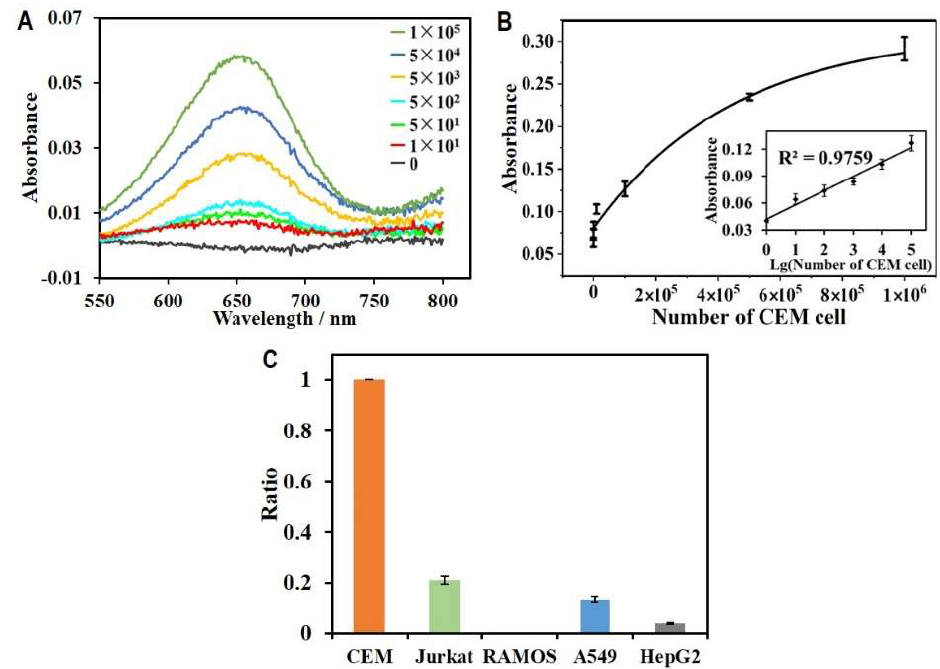
Figure 5. Application of the HGN-based aptasensor for quantification of CEM cells. ( A ) The UV-vis absorption spectra recorded by the HGN-based aptasensors for detecting various concentrations of target CEM cells with cell amount from 0 to 10 5 . ( B ) The relationship between absorbance intensity and the cell concentration. The inset shows the linear calibration curve between absorbance intensity and the logarithm of cell number. ( C ) Absorbance intensity ratio of control cells (including Jurkat, RAMOS, A549 and HepG2 cells) relative to the target CEM cells determined by the aptasensor.